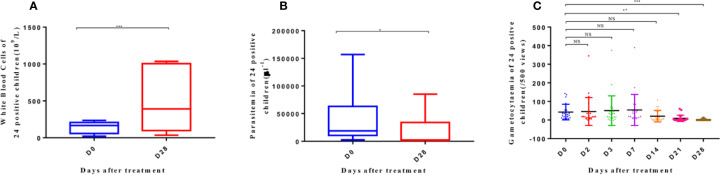
White blood cells (A), parasitemia (B), and gametocytemia (C) of 24 patients with positive parasite detection after treatment on D0 and D28. The significance levels are shown as: significant (***: p < 0. 001; **: p < 0. 01; *: p < 0. 05) and nonsignificant (NS). White blood cells and parasitemia of 24 patients were analyzed with one-way ANOVA, and gametocytemia was analyzed with one-way ANOVA and multiple comparisons. Error bars show the standard error of the mean (SEM).